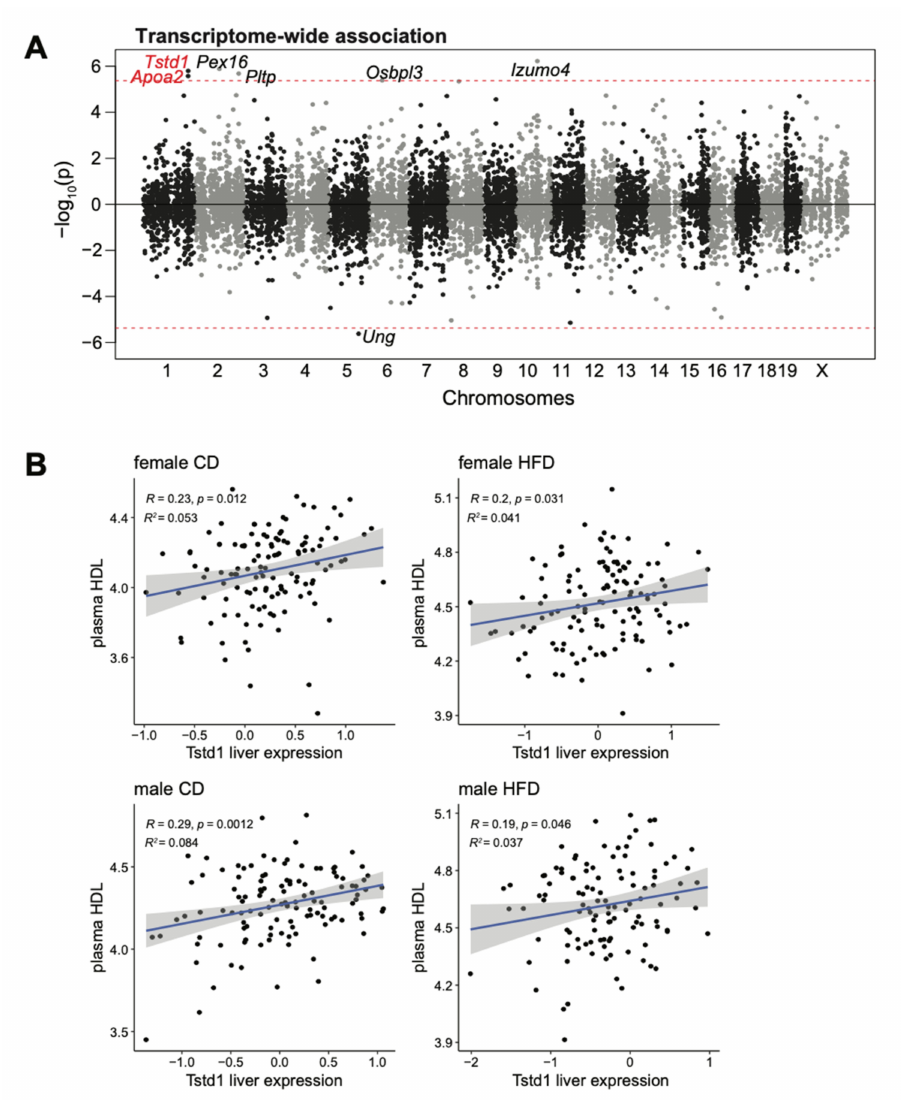
Figure 3. Transcriptome-wide association study (TWAS) further confirmed the association between the plasma HDL and Tstd1 . ( A ) Manhattan plot depicting the associations of transcripts with positive effects (increased expression leads to higher HDL levels) and transcripts with negative effects (increased expression leads to lower HDLs). Transcripts were plotted across the chromosomes with x-axis as the chromosome coordinates and y-axis as the significance of the association. The threshold for transcriptome-wide significance was determined based on the number of transcripts tested ( p < 4.2 × 10 − 6 , red dashed line). ( B ) Correlations between Tstd1 liver expression and plasma HDL levels in the DO mouse cohort. Individual animals were divided into four groups based on their sex and diet conditions. The Pearson’s correlation coefficient and significance were